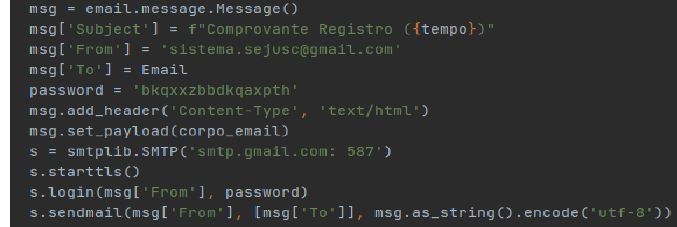
Figure 17: Process of sending the e-mail.